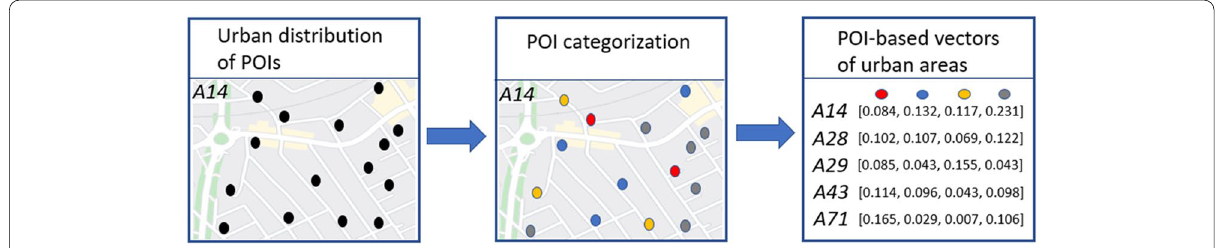
Fig. 3 POI-based vector definition framework